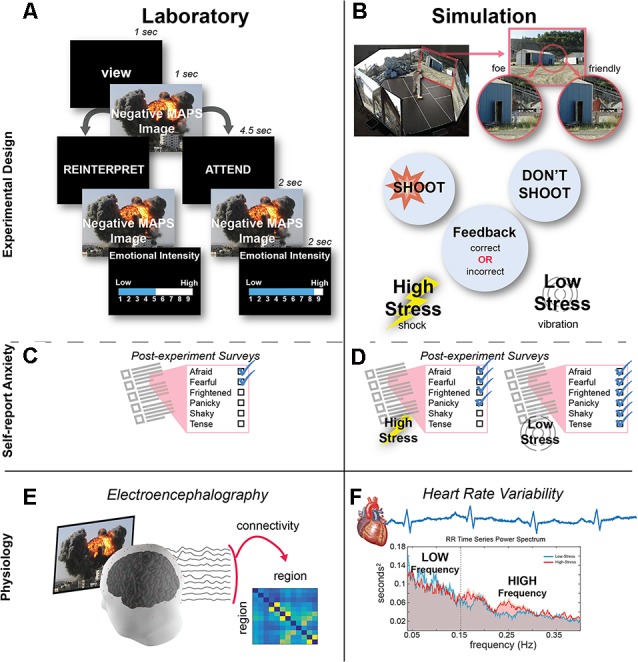
Experimental design. (A) In the laboratory session, participants performed an emotion regulation task. After naturally viewing the image during the first presentation, either a REINTERPRET or ATTEND cue appeared to indicate whether the participant should regulate their emotion or naturally view the image during its second presentation. The trial ended after participants rated the emotional intensity during the second image presentation. (B) In the 300 degree simulation, participants had to discriminate whether two human characters were both friendlies or one foe and one friendly (depicted). Participants received feedback when they made an error (failing to shoot a foe or incorrectly shooting a friendly): in the high-stress condition, feedback was provided as an electrical shock, while in the low-stress condition, feedback was a vibration. (C) At the end of the laboratory session, participants completed a self-report anxiety questionnaire. (D) After each simulation condition, participants completed a self-report anxiety questionnaire. (E) Brain activity was recorded from the scalp during the laboratory task, and then timeseries data from 12 electrodes were used to compute functional connectivity among each electrode pair. (F) Heart activity was recorded during the simulation task, and then heart rate variability (HRV) was computed and averaged to derive the low-fequency (LF) and high-frequency (HF) components.